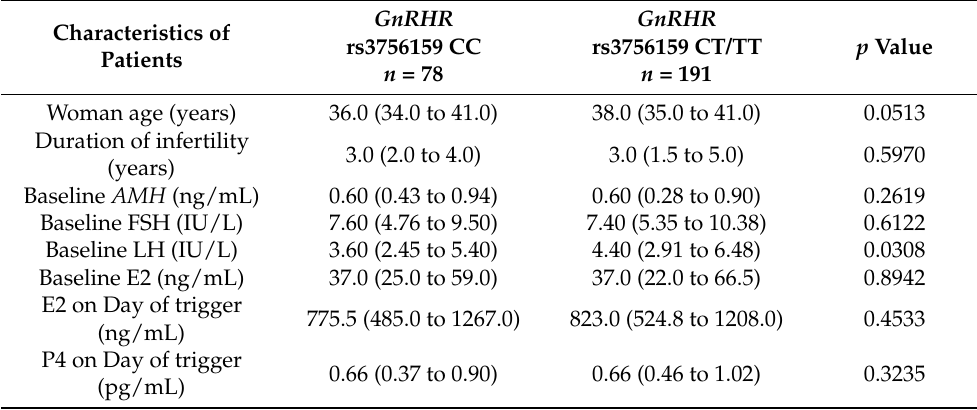
Table 6. The demographic and ovarian stimulation characteristics of infertile woman in GnRHR (rs3756159) SNP with CC vs. CT/TT genotype. The data are presented with median (25% to